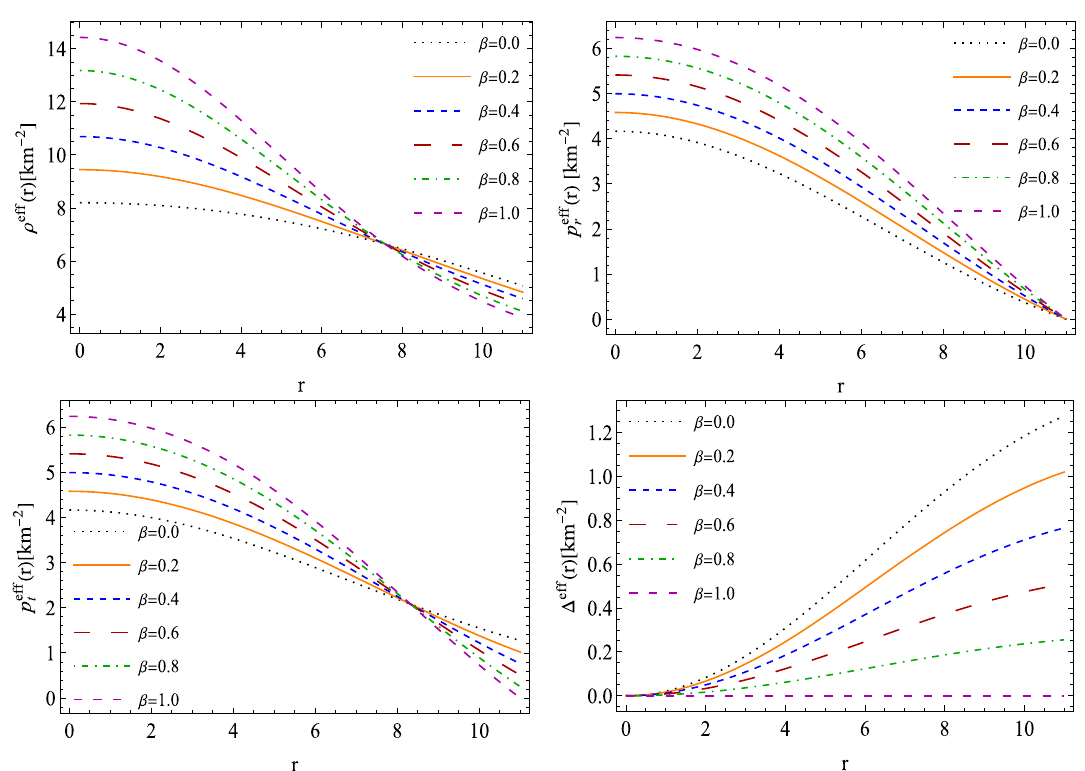
figures. We use the following numerical values, A = 0 . 0078 km − 2 and B = 0 . 0093 km − 2 , α = 1 . 2 km − 2 , and β = 10 − 46 , to plot